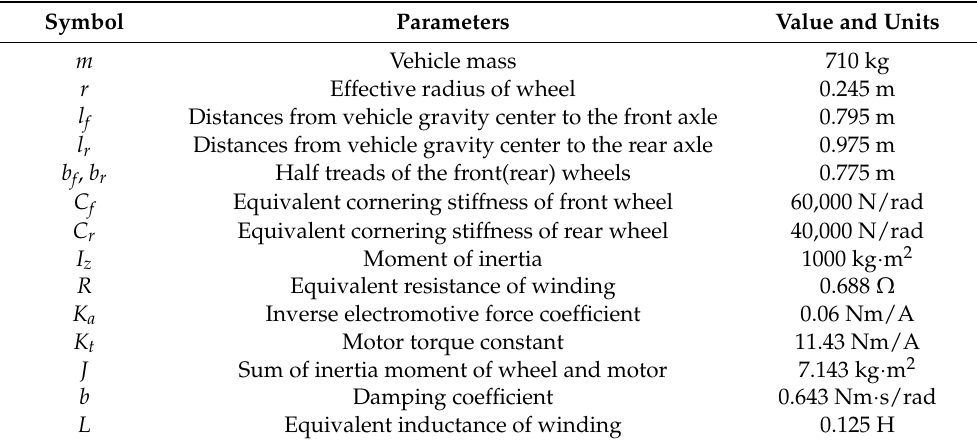
Table 2. Parameters of the vehicle, tires and in-wheel